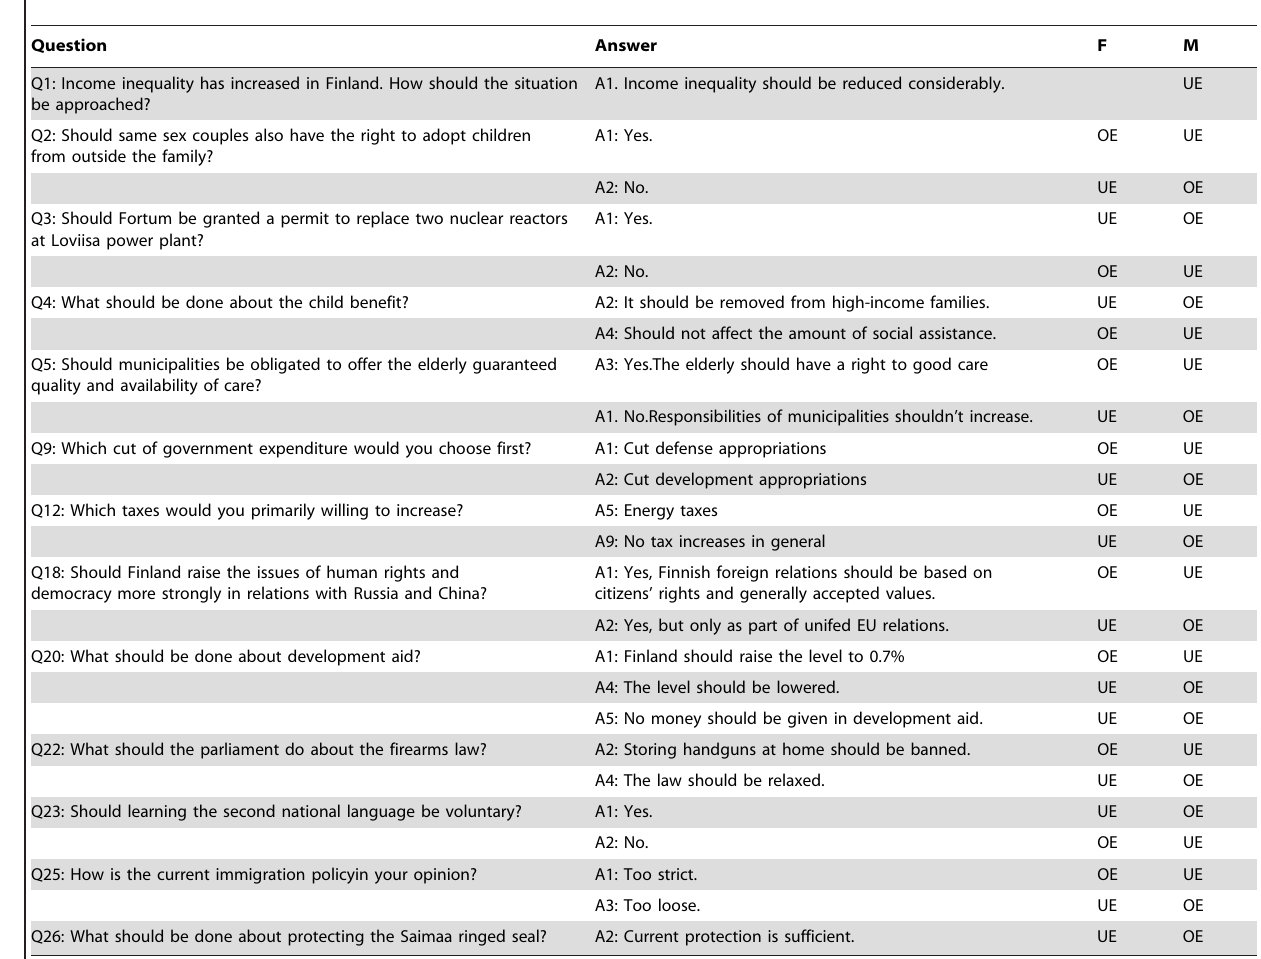
Table 2. Over-expressed (OE) and under-expressed (UE) endorsement of a specific answer (second column) given to the related question (first column) by candidates of different